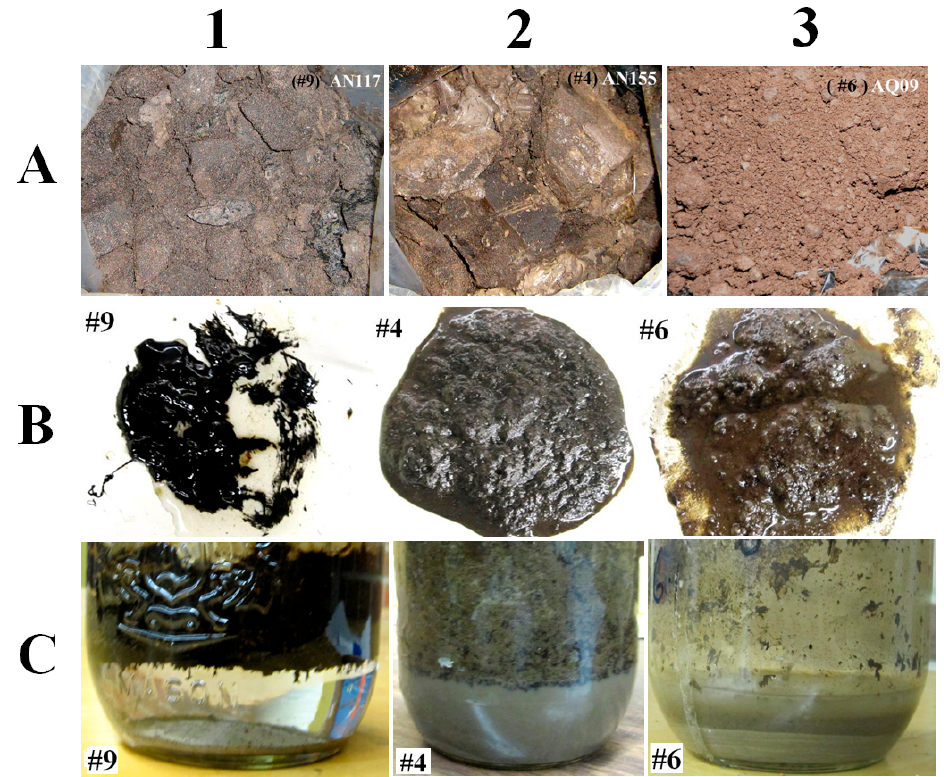
Figure 2. Photos of three oil sand ores in row ( A ) (Sp#4, 6, 9), the resulting froth in row ( B ), and segregation once stored in jar as shown in row ( C ).